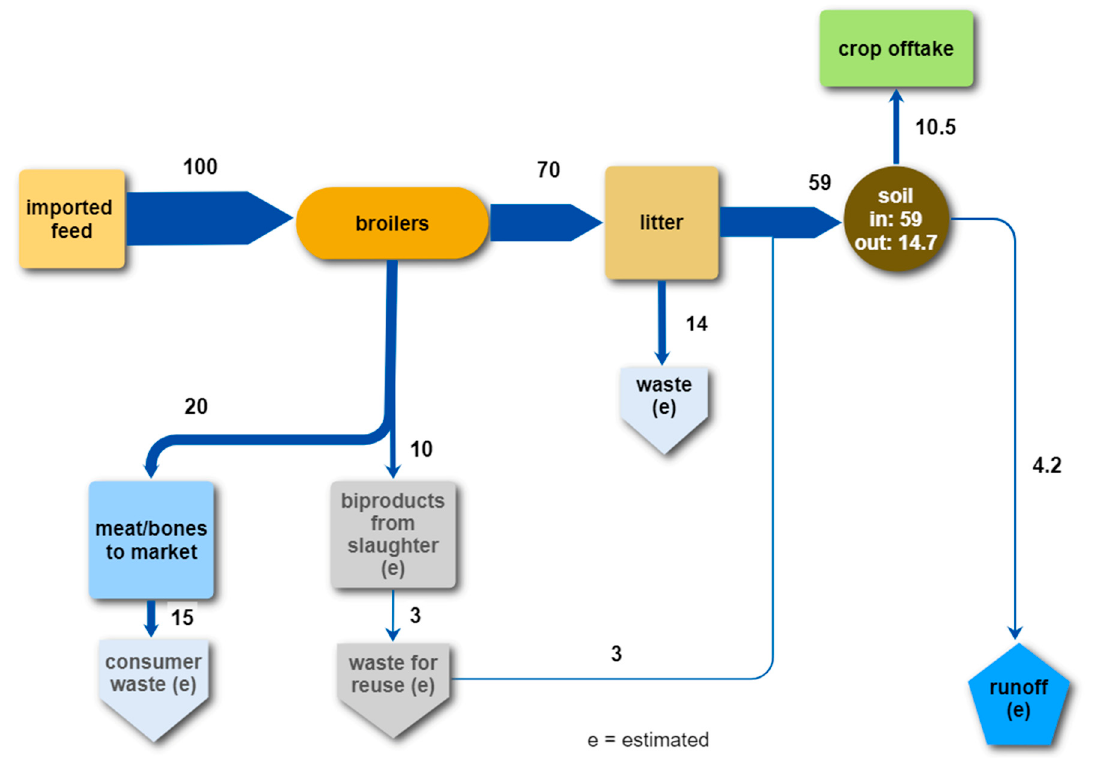
Figure 6. Relative annual P flow dynamics for broilers with feed set to 100% (based in part on data from Sharpley [71]). Soil deposition level and runoff losses will vary from case to case, depending on local soil type, soil P levels, cover crops, precipitation, and topographic conditions.